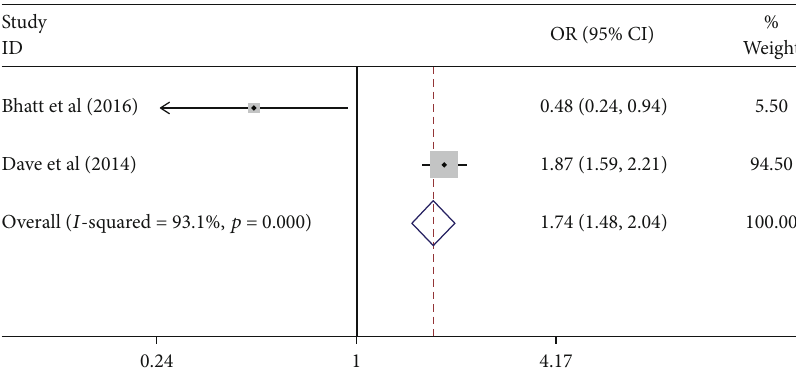
Figure 10: E ff ect size of atrial fi brillation on the uncontrolled hypertension. Funnel plot with pseudo 95% confidence limits 0